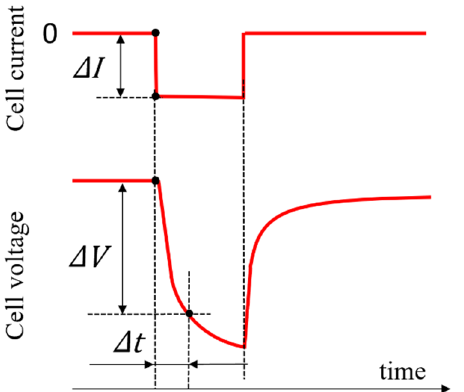
Figure 3. Current voltage step test for cell internal resistance